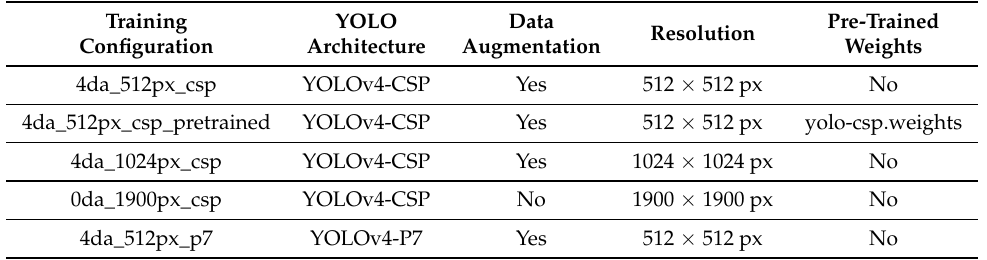
Table 2. Training studies for grapevine’ shoots detection and classification